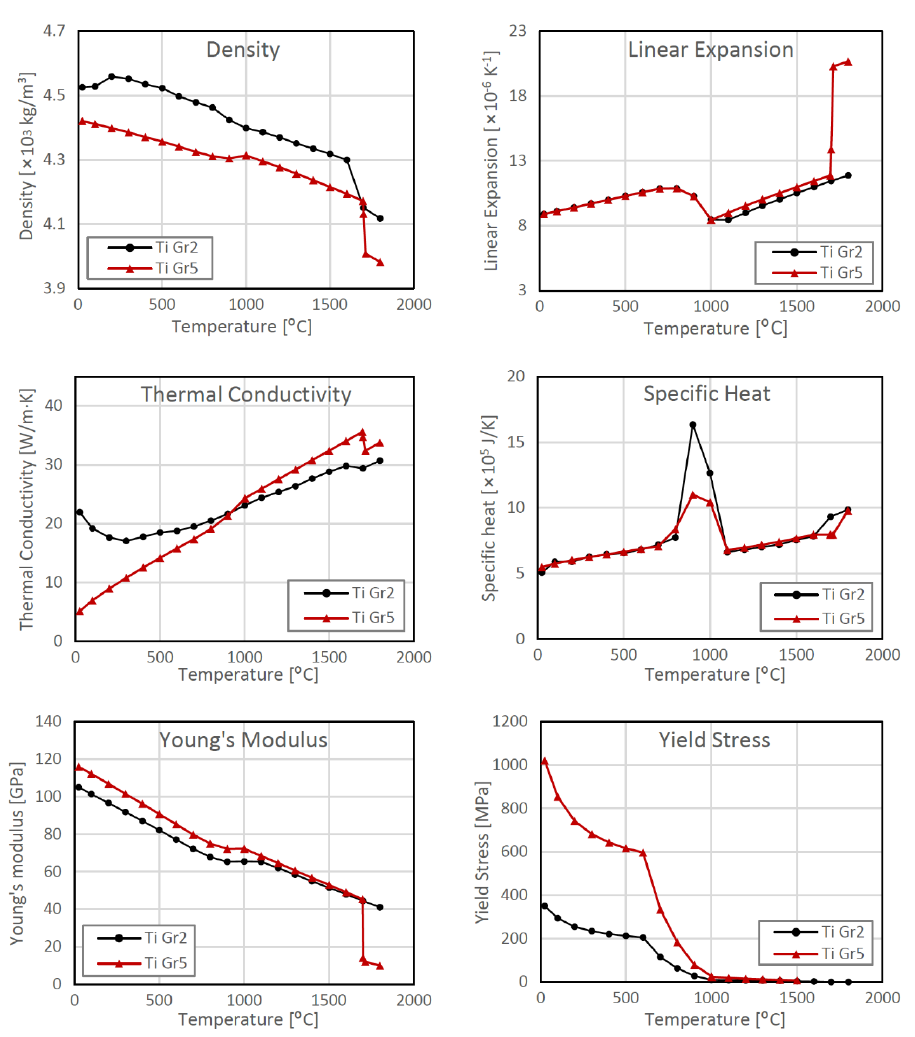
Figure 8. Thermo-mechanical properties of Titanium grades 2 and 5.